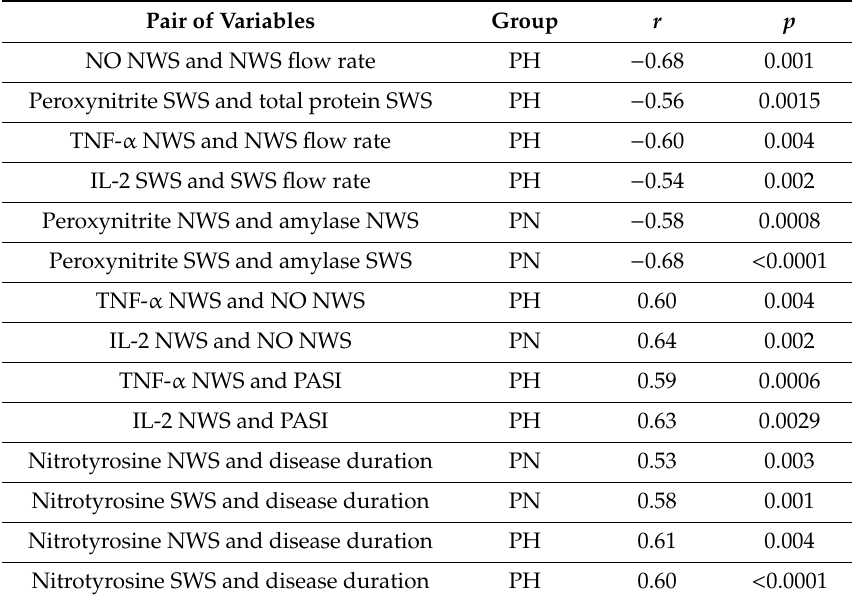
Table 4. Statistically significant correlations in patients with plaque